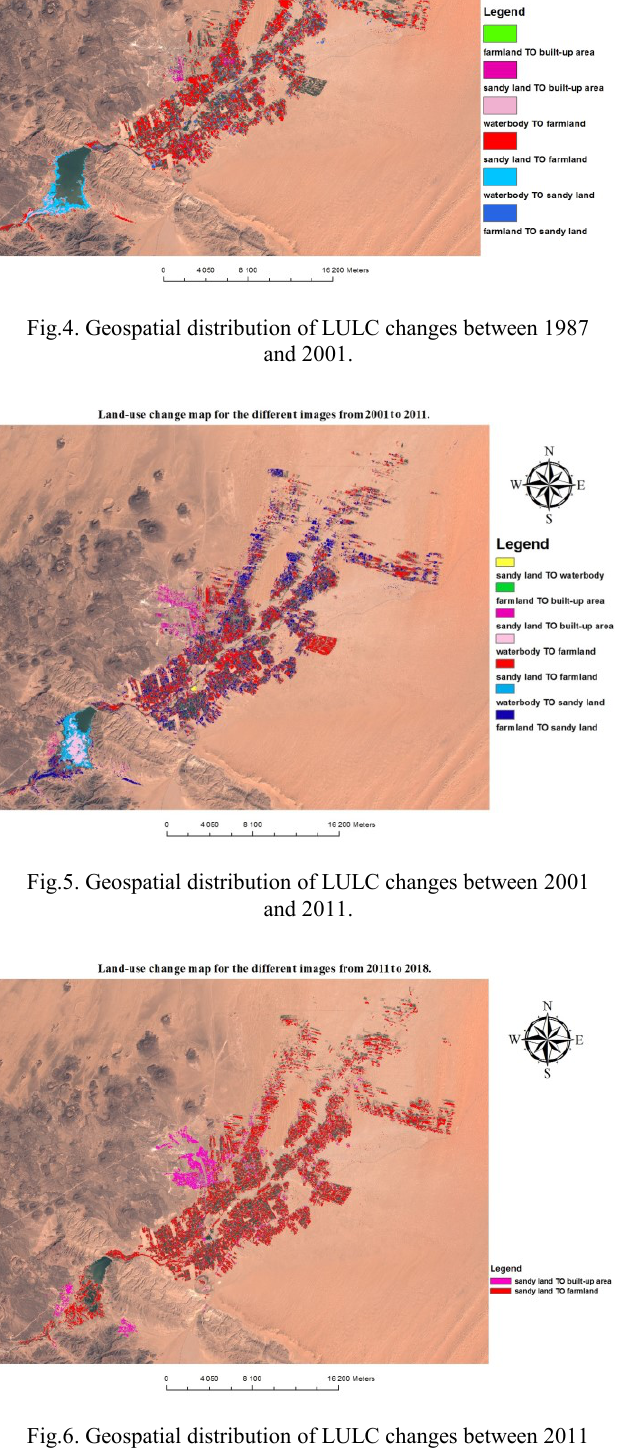
Fig.6. Geospatial distribution of LULC changes between 2011 and 2018.